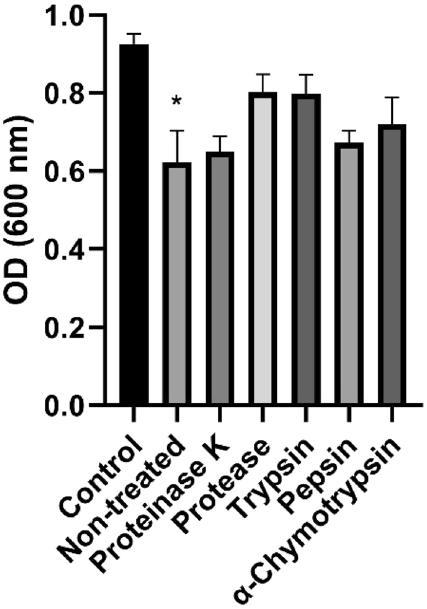
Figure 3. Optical density (OD) of Gardnerella vaginalis suspension incubated for 24 h with 5% (v/v) fraction below 3 kDa from Lactobacillus paracasei CH88 cell-free supernatant treated with different proteolytic enzymes. Bars are means and standard errors of the means (n = 3) of triplicate experiments. *Significant difference compared to the control ( p < 0.05; one-way ANOVA with Dunnett’s multiple comparison